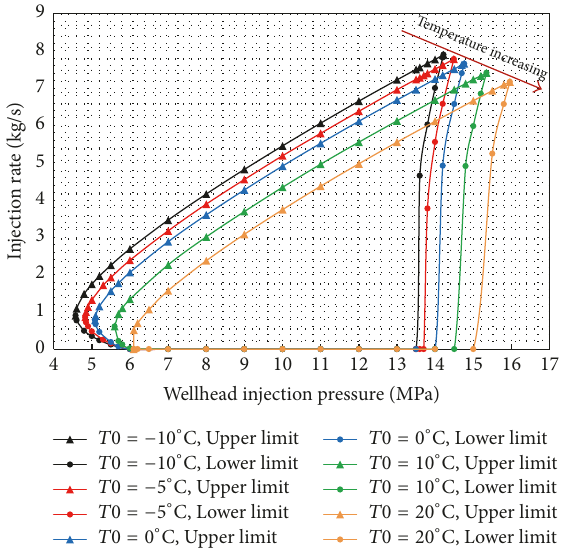
Figure 6: Relationship diagram between wellhead injection pres- sure and injection rate at different temperature of injected fluid.